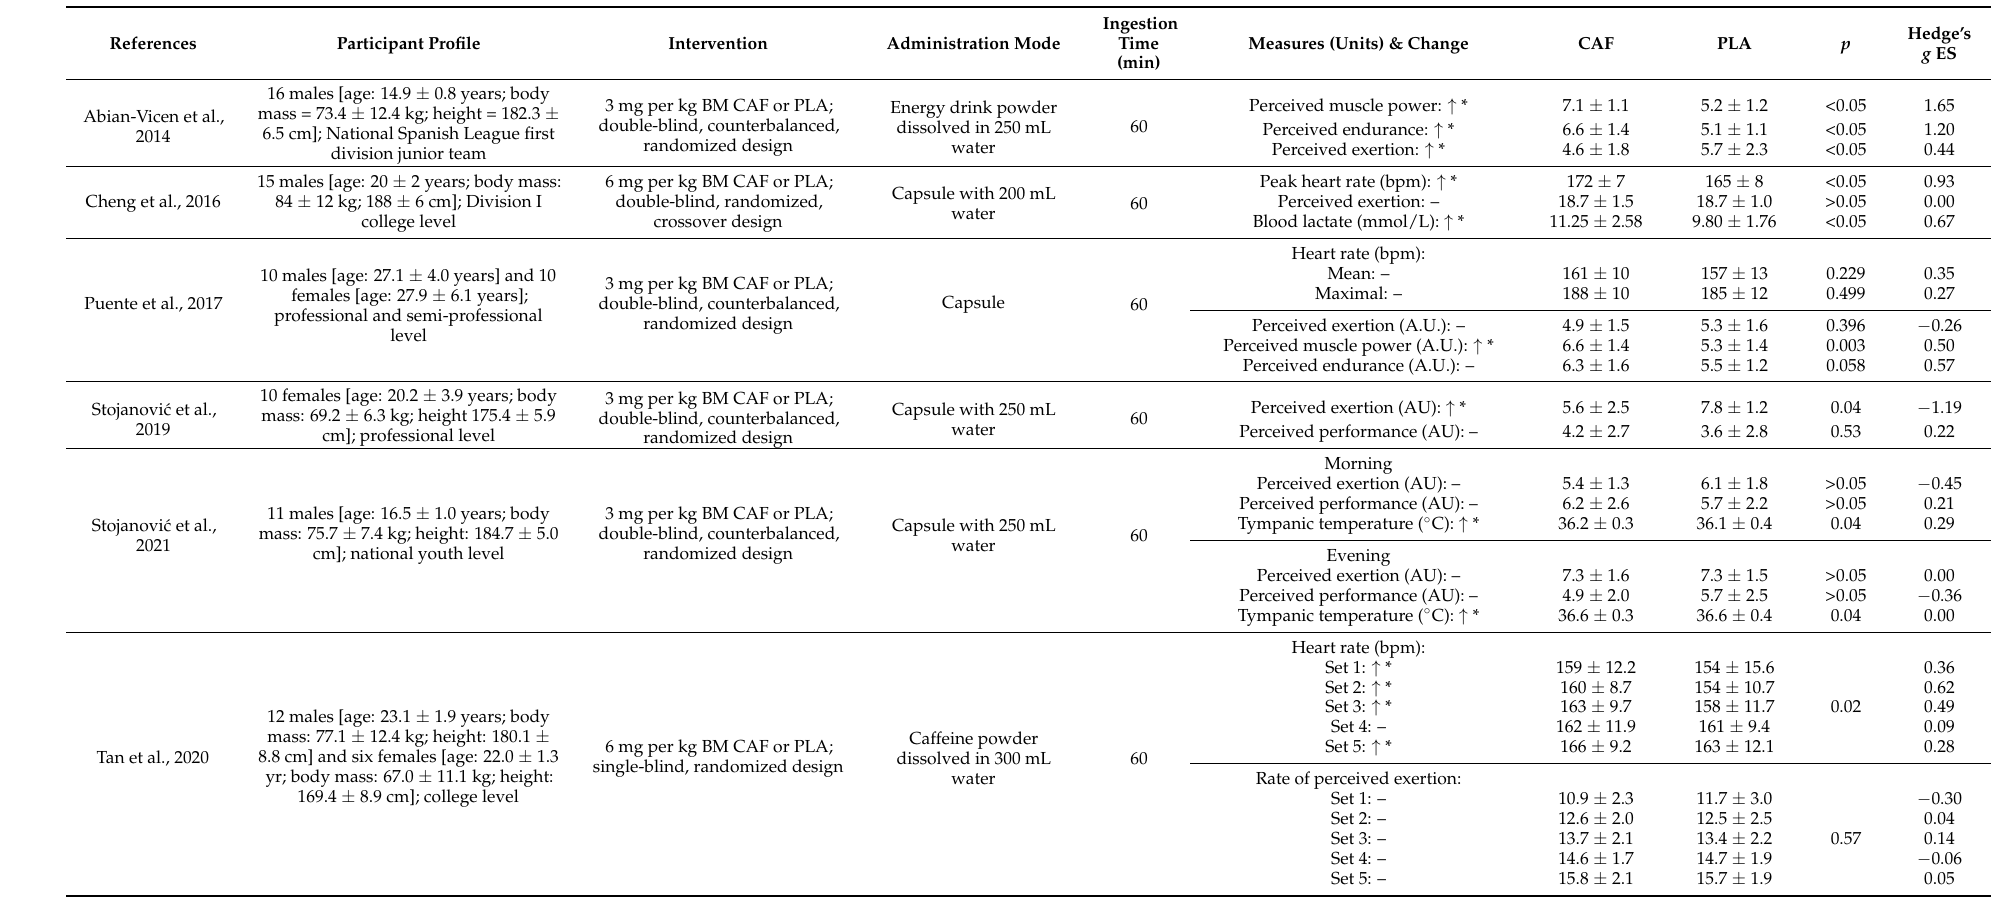
Table 4. Effect of caffeine on physiological responses of basketball